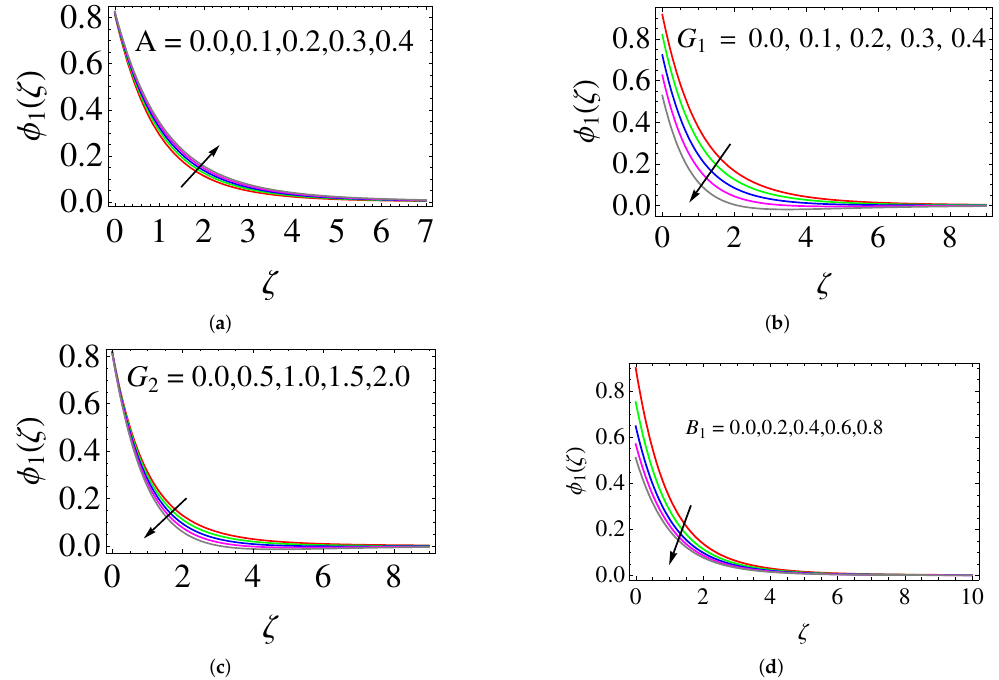
Figure 6. Influences of ( a ) velocity slip ( A ) , ( b ) thermal stratification ( G 1 ) , ( c ) nanoparticle volume fraction stratification ( G 2 ) and ( d ) thermal slip ( B 1 ) parameters on temperature profile for M = 0.2, Rd = 0.1, Nt = 0.1, θ w = 0.1, Nb = 0.1, Pr = 1.4, D f = 0.2, Sc n = 1.9, Sc = 0.4, S r = 0.2, γ = 0.1, C r = 0.1, G 3 = 0.1 and B 2 = B 3 =